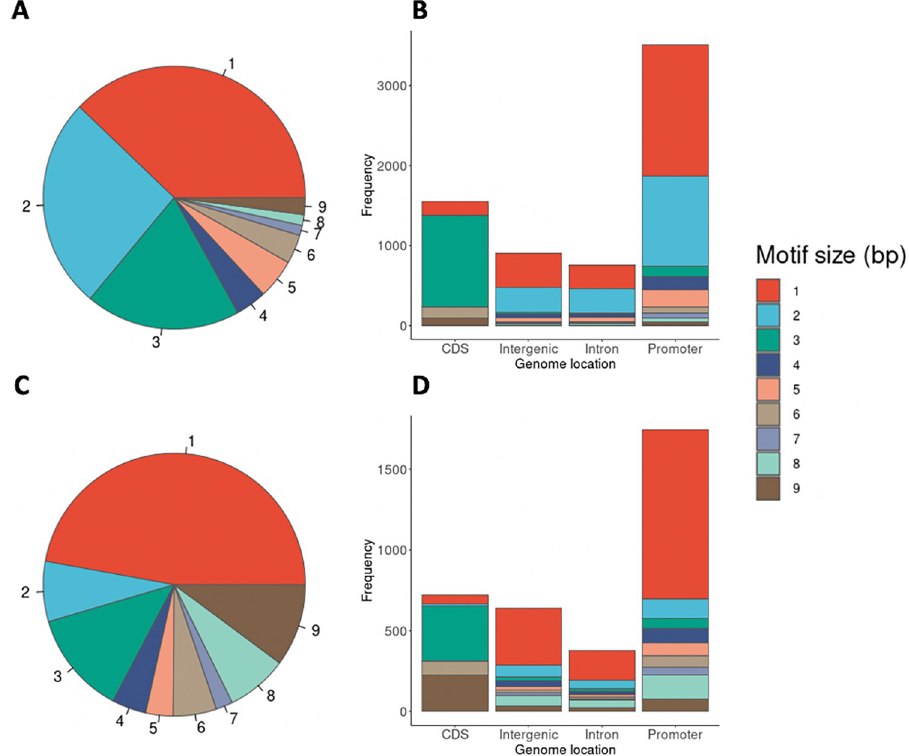
Fig 2. STR mutation distributions of the P . falciparum and P . vivax samples. (A) Distribution of motif sizes (1–9 bp) of the 3,047 P . falciparum samples, colored by the motif size. (B) Distribution of motif size among various genomic features of the 3,047 P . falciparum samples. CDS represents coding DNA sequences. (C) Distribution of motif sizes of the 174 P . vivax samples. (D) Distribution of motif size among various genomic features of the 174 P . vivax samples. The genomic features are labeled along the X-axis for (B) and (D). The frequencies of each motif size are calculated as the total bases covered by STRs of a given motif size divided by the total bases covered by all STRs, labeled along the Y-